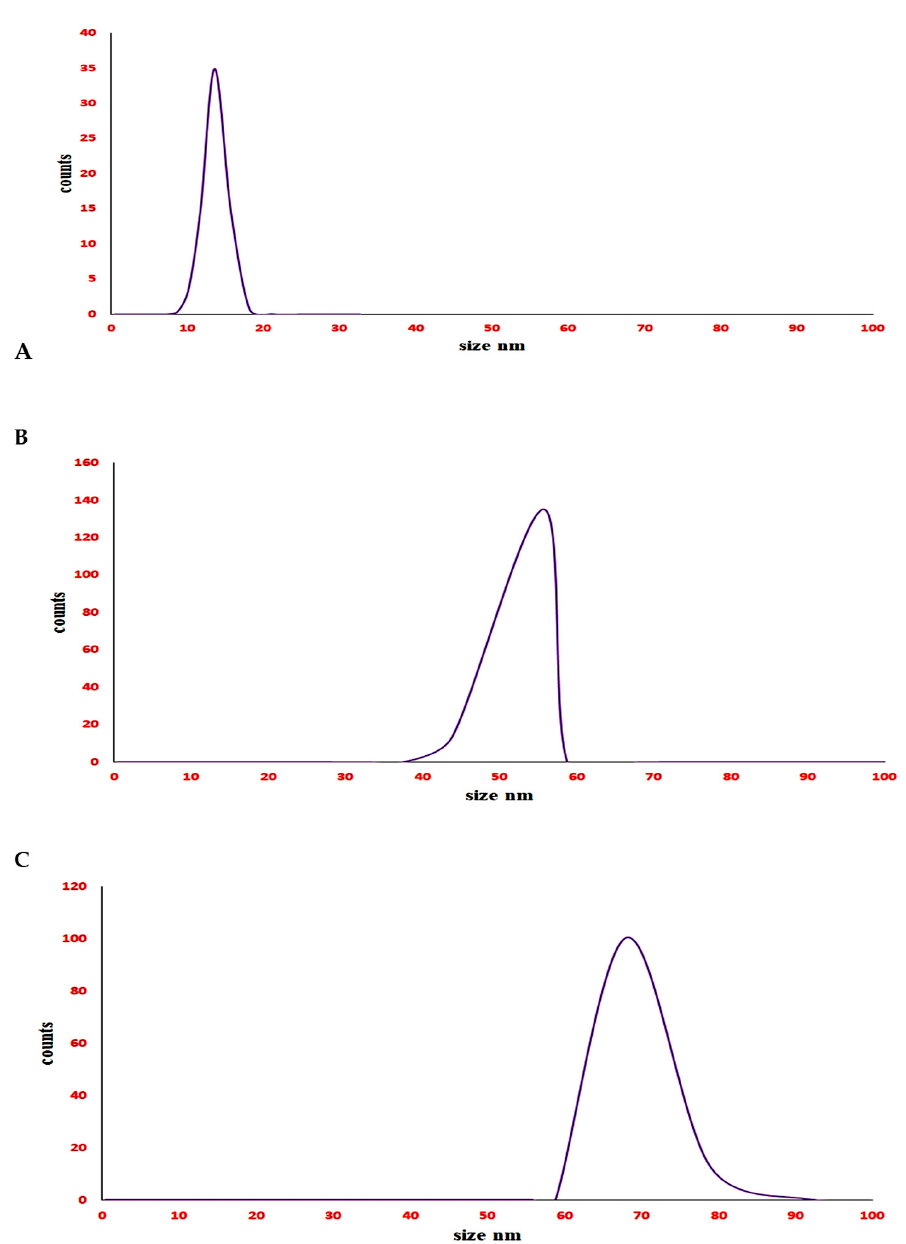
Figure 3. DLS for ( A ) silver nanoparticles (AgNPs); ( B ) silver mung bean protein nanocomposite (Ag-MNP), and ( C ) silver fenugreek protein nanocomposite (Ag-FNP).